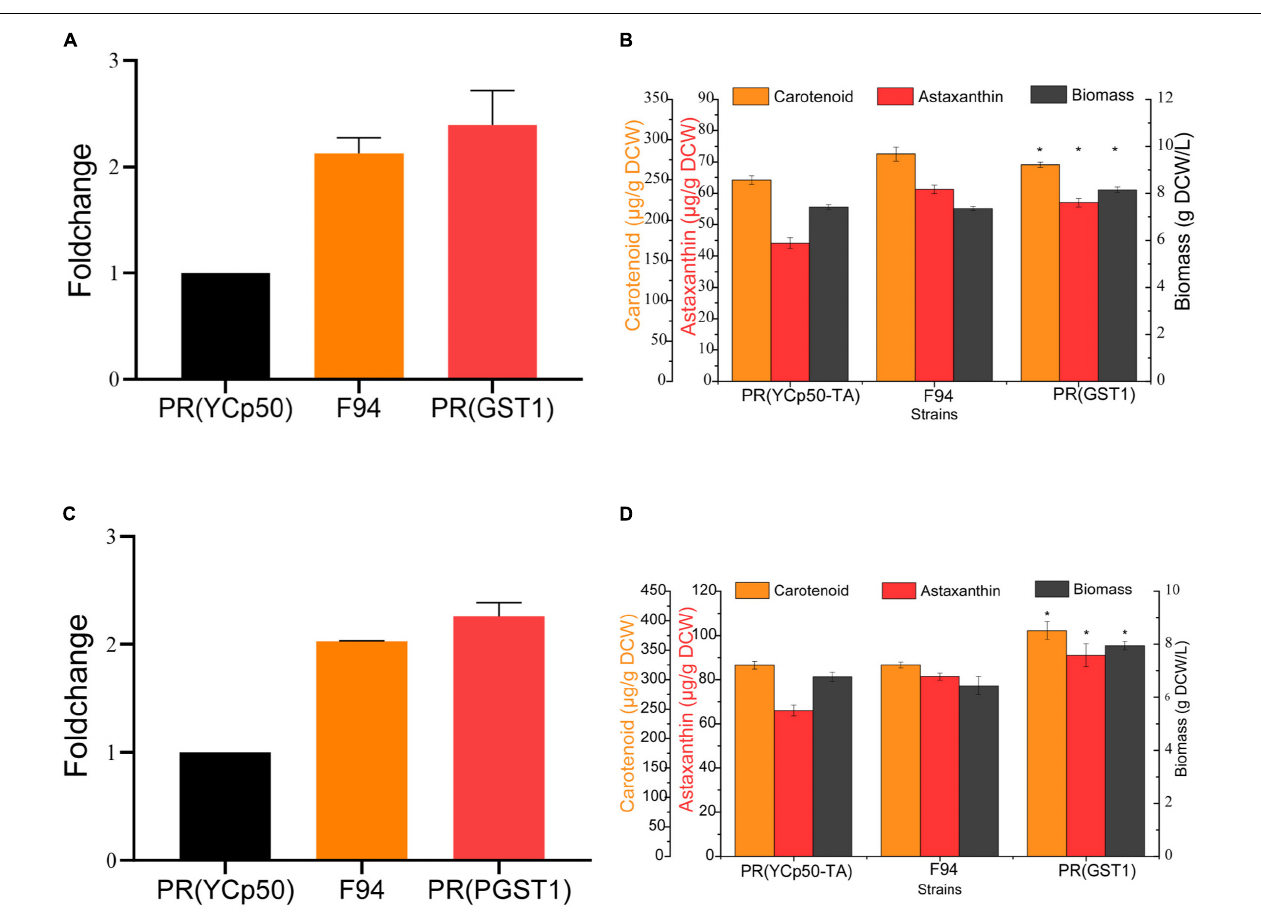
FIGURE 7 | Analysis of GST1 transcription level and the growth and carotenoid synthesis ability of GST1 overexpression strain. (A) Analysis of GST1 transcription level of PR (YCp-TA), F94, and PR (GST1) strains in YPD media. (B) Analysis of the growth and carotenoid synthesis ability of PR (YCp-TA), F94, and PR (GST1) strains in YPD media. (C) Analysis of GST1 transcription level of PR (YCp-TA), F94, and PR (GST1) strains in YM media. (D) Analysis of the growth and carotenoid synthesis ability of PR (YCp-TA), F94, and PR (GST1) strains in YM media. Statistical analysis was performed using Student’s t -test (* p < 0.05).